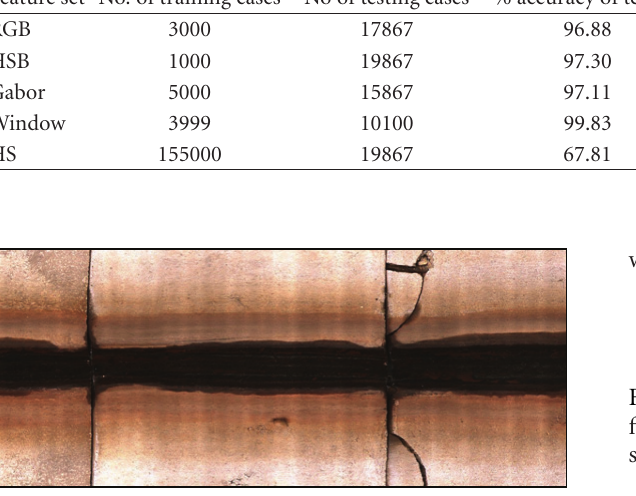
Figure 10: Typical example of flow lines, pipe joints, and adjoining defects.